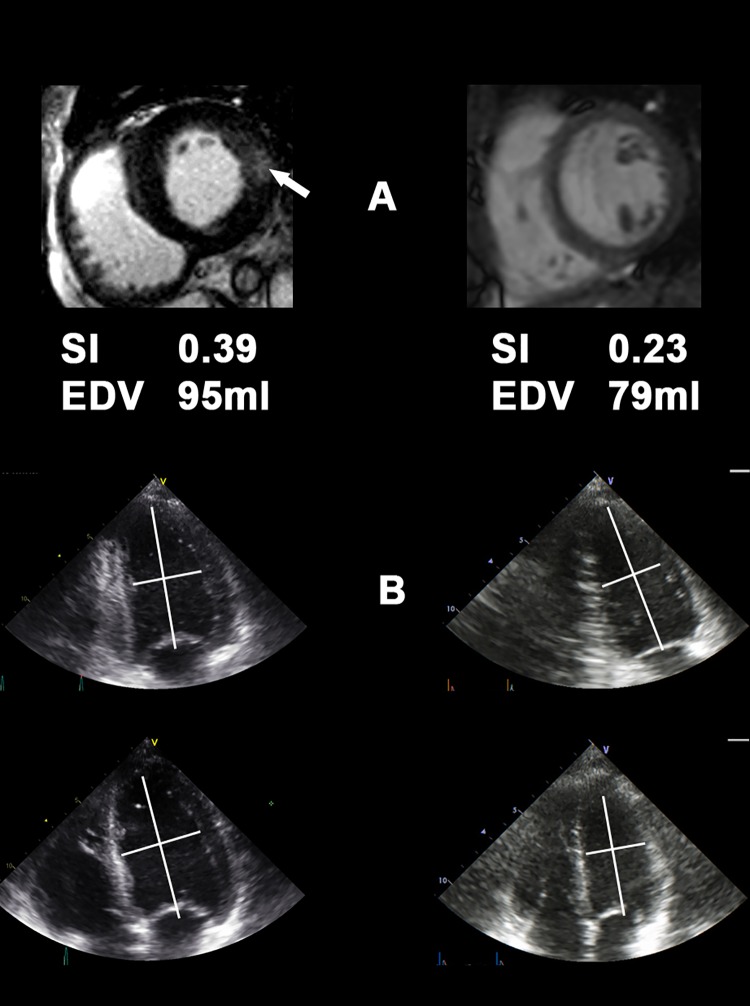
Typical cardiac magnetic resonance imaging (cMRI) (A) and echocardiography (B) of patients with normal sphericity index (SI; right row) and elevated SI (left row).Note the pathological late enhancement (LE; white arrow) in the cMRI and the more spherical shape of the LV in the left row. SI; sphericity index, EDV; end-diastolic volume.